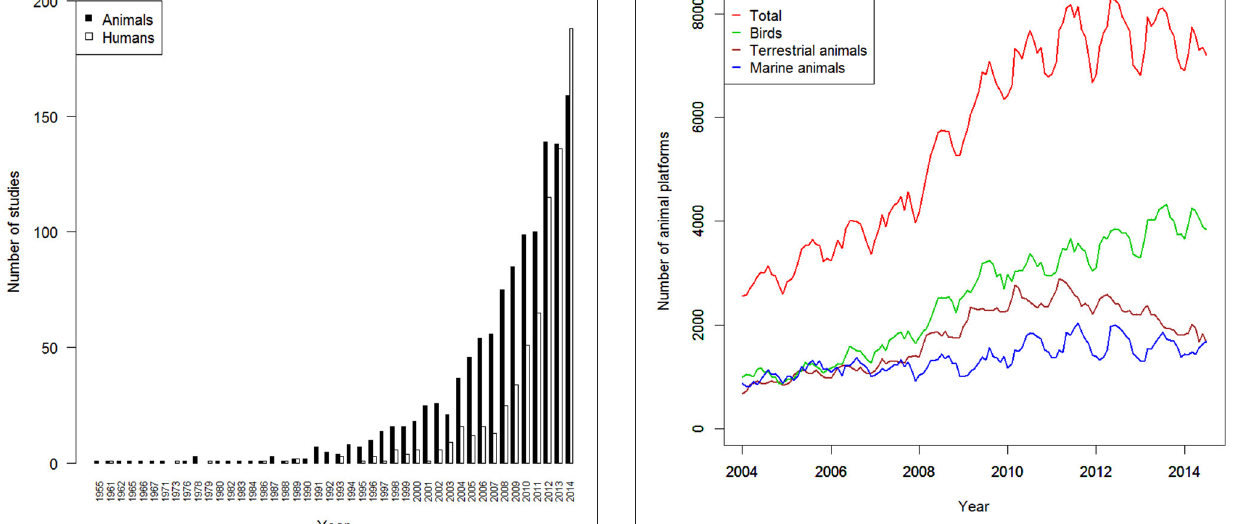
FIGURE 2 | Comparison of output from animal movement and human mobility research. Annual publication output in wild animal movement studies (black), and human mobility research (white). Data from ISI Web of Knowledge accessed June 1, 2015 using—“animal tracking” OR “animal movement” OR “animal telemetry,” and—“human tracking” OR “human mobility,” as search terms from 1945 to 2014. Search results from human mobility research were vetted for studies related to the biomechanics of human mobility and these were deleted.